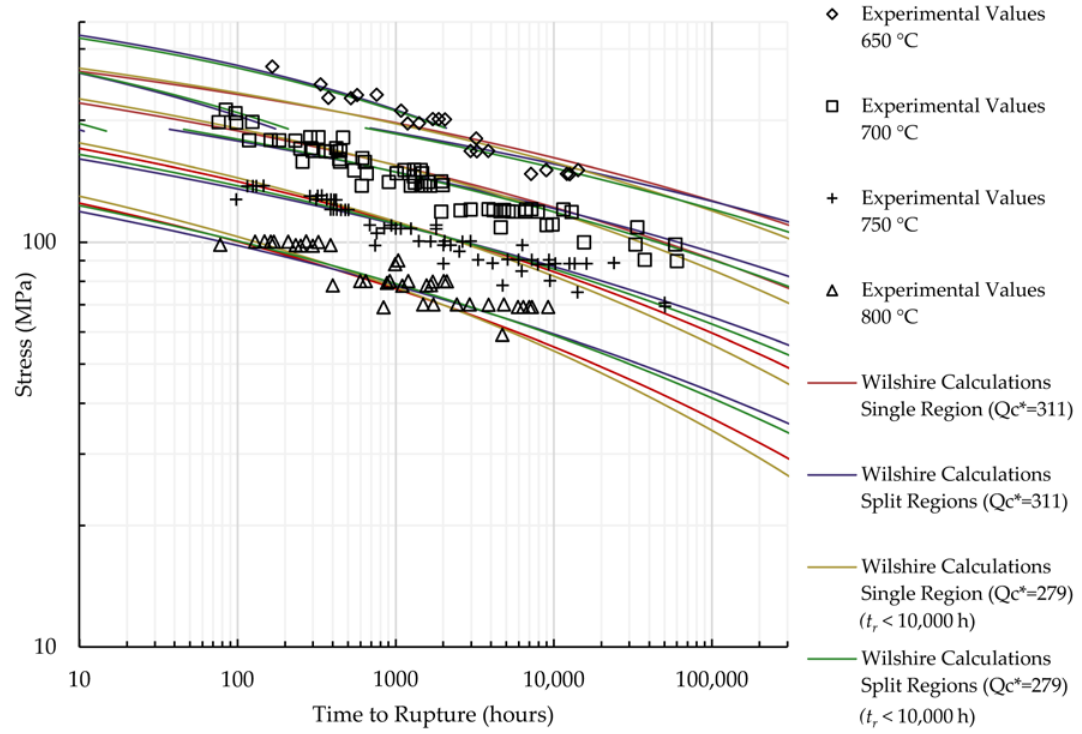
Figure A7. Calculations of the Wilshire equation for HR6W with Q ∗ plots.